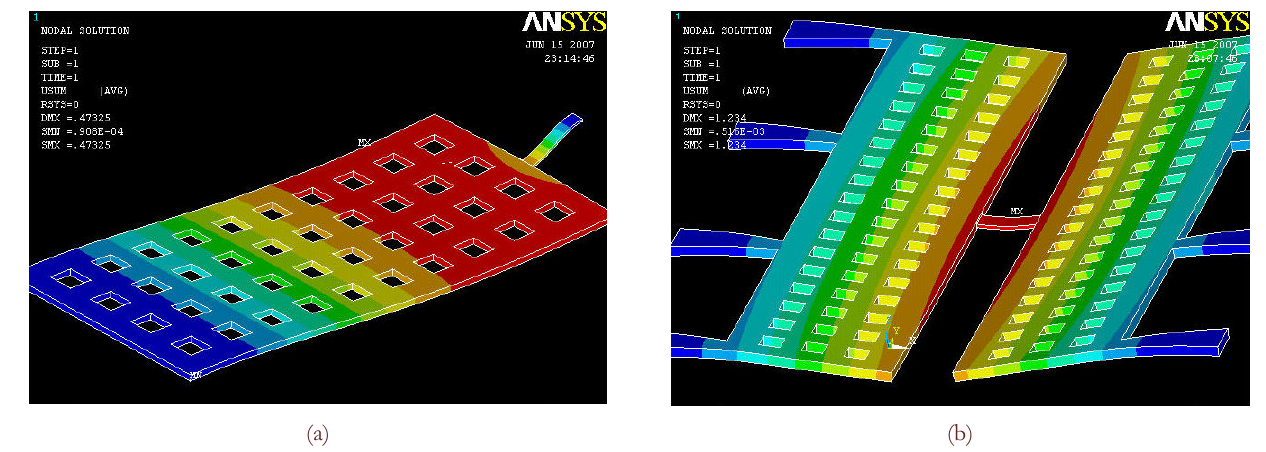
Figure 3: FEM Von Mises equivalent stress distribution on the devices for shear and flexural (a) and tensile (b) fatigue